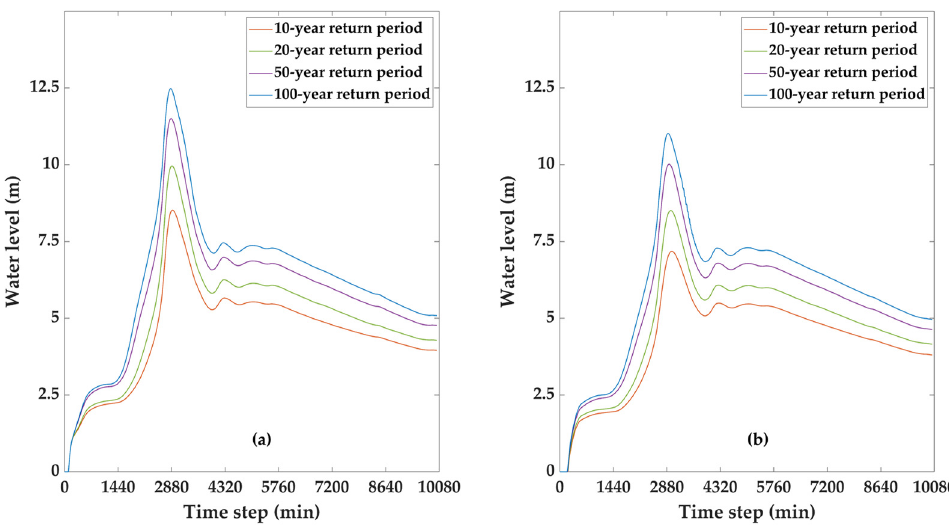
Figure 6. Water level series at hydrometric stations in different return periods: ( a ) HHS; ( b ) MHS. The evolution processes of floodwater in the polder are shown in Figure 7. After flowing into the polder through the dike break, floodwater rushes towards the west rapidly. Meanwhile towards the north, there are two low-lying lands located, respectively, in the middle and western area, resulting in the concentration of floodwater. For a 20-year return period, the dike break occurs at the time of 2725 min. The inundated area increases during the following 10 h, reaching the maximum value of 3.27 km 2 at nearly 3350 min. It is merely flooding in 20-year return period that generates nearly the whole polder area (Figure 8). For a 50-year return period, the dike break occurs at the time of 2595 min. The inundated area then rises quickly, reaching 3.75 km 2 at roughly 3250 min. The maximum of water depth reaches over 1.8 m in most low-lying lands (Figure 9). For a 100- year return period, the dike break occurs at the time of 2475 min. After that, the floodwater spreads extremely fast in the polder area, reaching 3.87 km 2 at the time of 3000 min. Then, the water depth in inundated areas grows gradually, the most severe inundation appears at the time of approximately 3250 min. Severe inundation occurs in the polder, as over two meters of floodwater covers most areas (Figure 10). There are no efficient drainage systems to deal with floodwater inundation in the polder area, except two pumps. Once dike breaks occur, severe waterlogging will spread in the polder area quickly, increasing the flood risk of buildings.